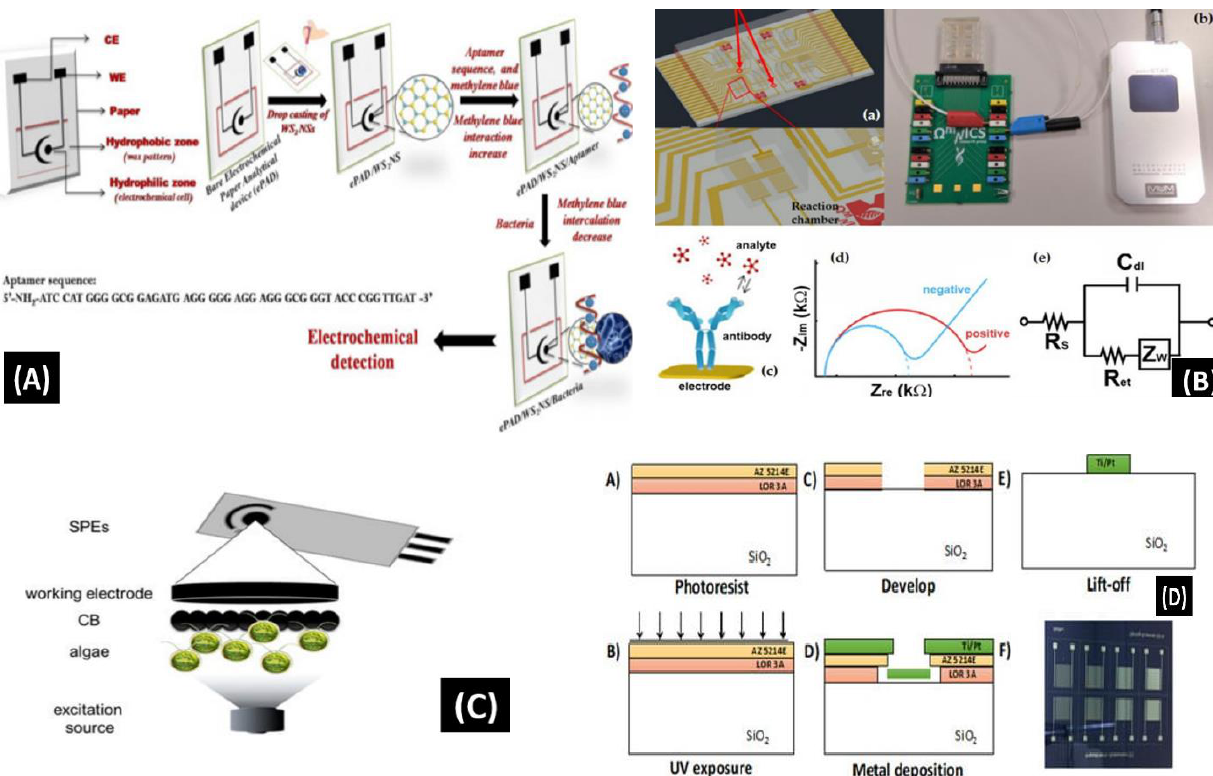
Figure 7. ( A ) Schematic of the screen-printed paper-based aptasensor for the detection of Listeria monocytogenes [90] . ( B ) Schematic representation of the LOC device optimized for the detection of GLRaV-3 and GFLV [140] . ( C ) Scheme of the proposed algal/CB-SPE cytosensor [141] . ( D ) Microfabrication procedure for platinum interdigitated electrodes on SiO 2 wafers [142].